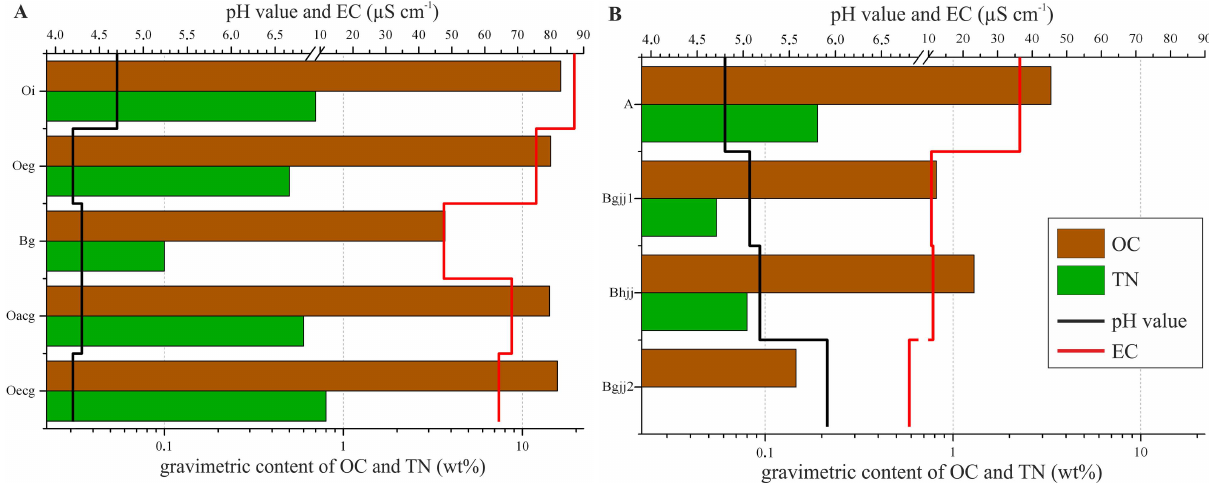
Figure 12. Chemical analyses of in Figs. 3 and 4 presented permafrost-affected soils. (A) Chart for Typic Historthel. (B) Chart for Typic Psammoturbel. For better comparison, both charts use the same scaling. The upper scale is for the pH value and electrical conductivity (µScm − 1 ). Both properties were measured in a soil suspension of the soil sample and water. The scale at the bottom represents the contents of organic carbon (OC) and total nitrogen (TN) in %wt.